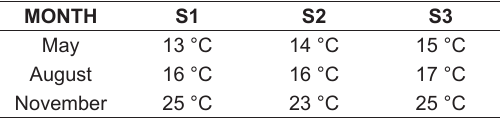
Figure 2. Composition of the granulometry of sampling sites. Very coarse sand (VCS); coarse sand (CS); medium sand (MS) and fine sand (FS). Particles size: silty clay = 3.90 - 62.5 μm; fine sand = 0.0049 - 0.010 mm; medium sand = 0.010 - 0.020mm; very coarse sand = 1 - 2 mm; coarse sand = 0.020 - 0.039 mm; pebbles = 64 - 256 mm; granules = 2 - 4 mm. Table 1. Temperature values (°C) recorded during the moment of the